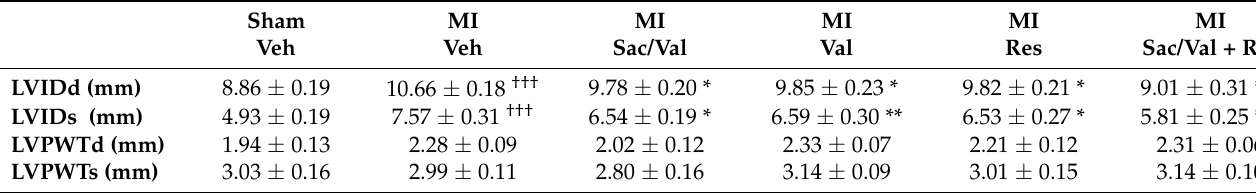
Table 1. Left ventricular internal diameter (LVIDd and LVIDs), and left ventricular posterior wall thickness (LVPWTd and LVPWTs) at diastole and systole of sham and MI rats. All values are expressed as mean ± SEM, n = 9–11. ††† p < 0.001 vs. Sham Veh; * p < 0.05, ** p < 0.01, *** p < 0.001 vs. MI Veh.